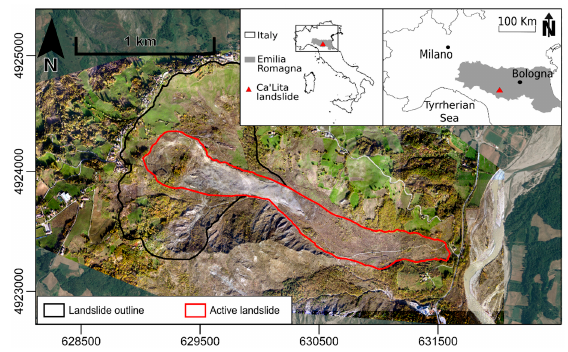
Figure 1. Ca’ Lita landslide location. Grid coordinates: WGS84/UTM32N (EPSG: 32632).